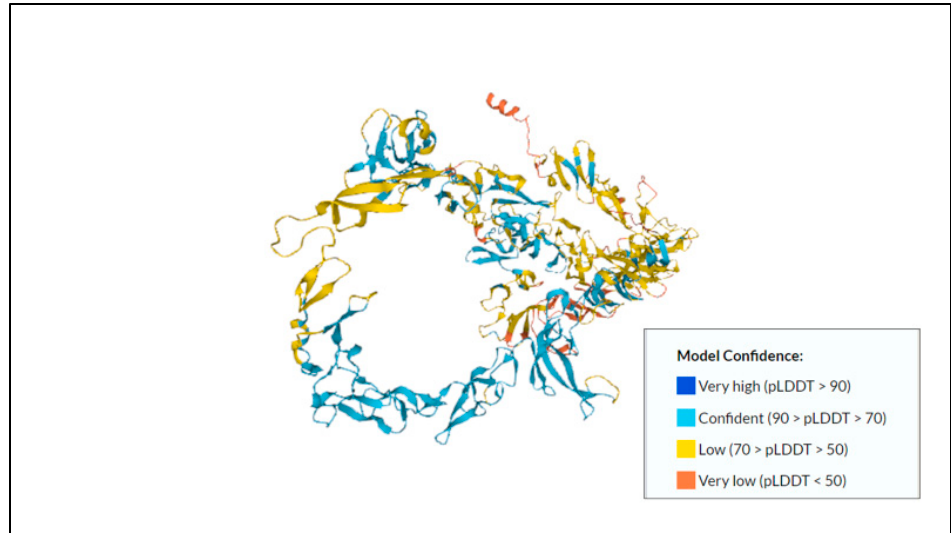
Figure 1. Predicted protein structure of Gal/GalNAc lectin Igl1 [40,41] (https://www.uniprot.org/uniprotkb/Q964D2/entry, accessed on 25 October 2022).